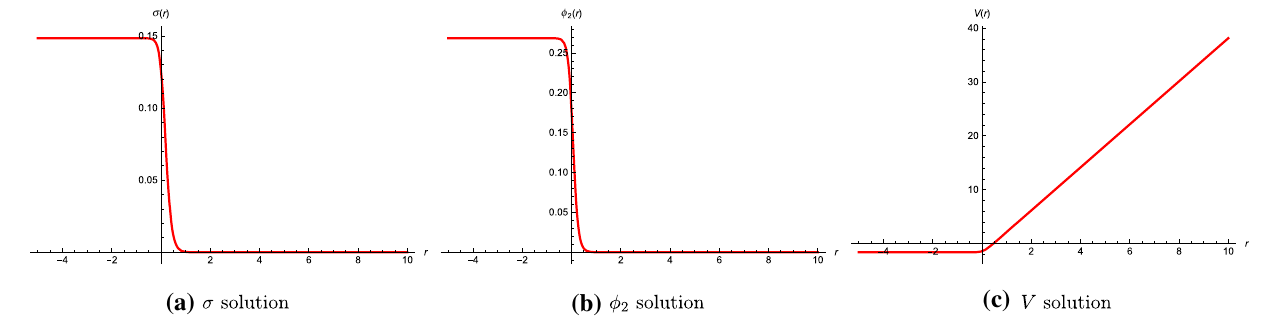
Fig. 11 An RG flow from SO ( 4 ) N = ( 1 , 0 ) SCFT in six dimensions to two-dimensional N = ( 2 , 0 ) SCFT with SO ( 2 ) diag symmetry dual to